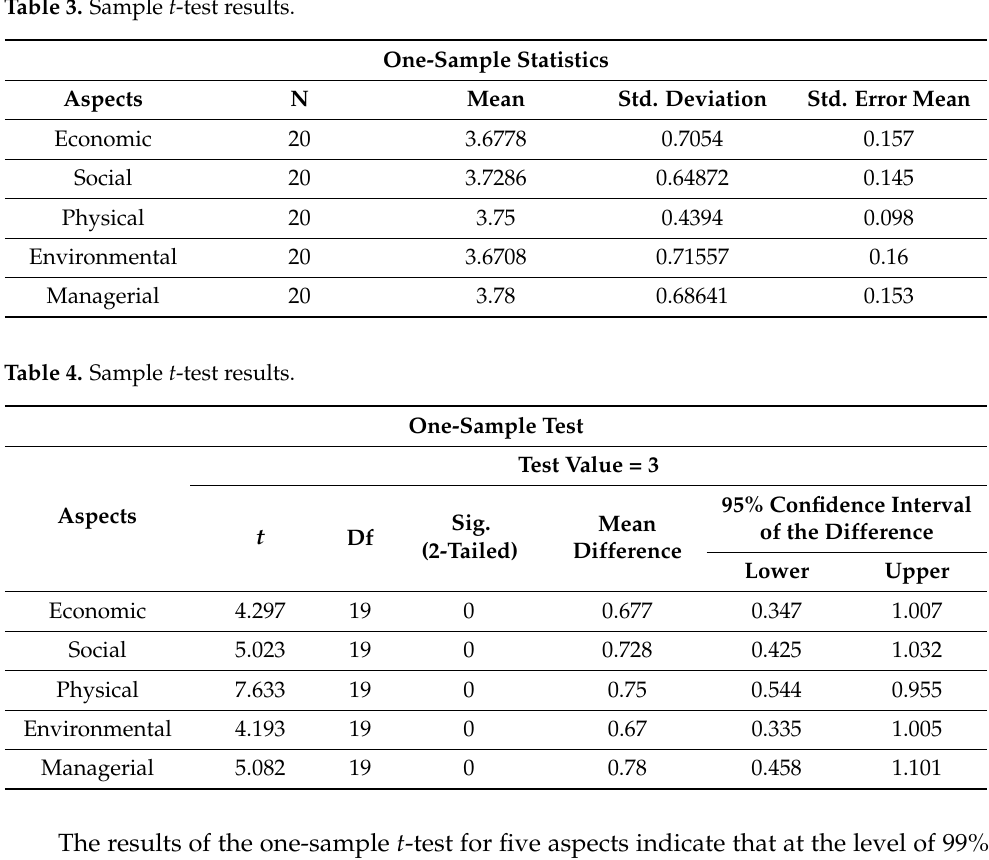
Table 3. Sample t -test results.